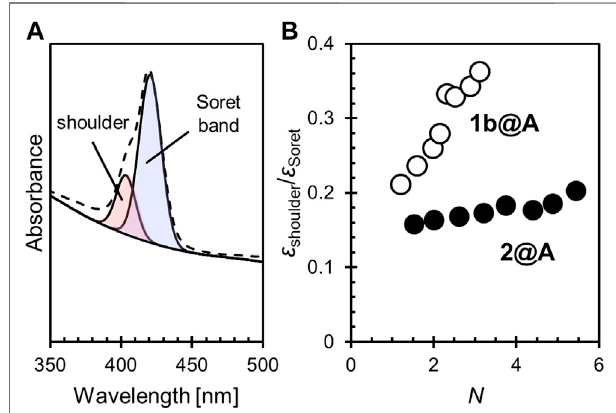
FIGURE 2 | (A) Spectral deconvolution of the Soret band and shoulder into two Gaussian curves. (B) The relative shoulder intensity ( ε shoulder / ε Soret ) of porphyrin adsorbates with different numbers of porphyrin – alkanethiolate adsorbates per particle ( N ).